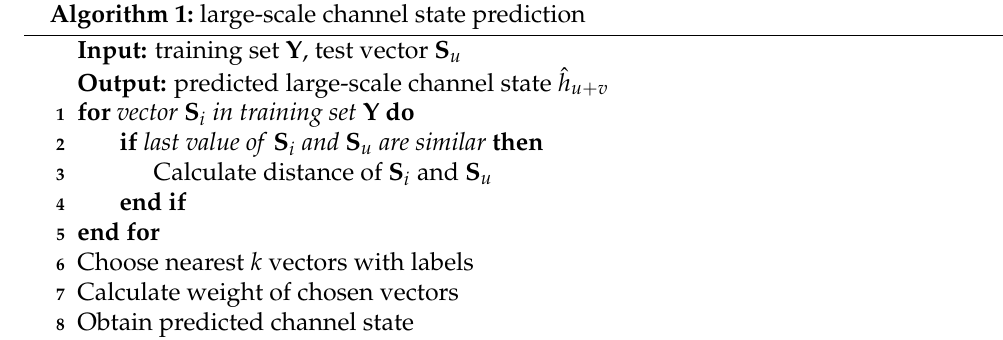
Algorithm 1: large-scale channel state prediction